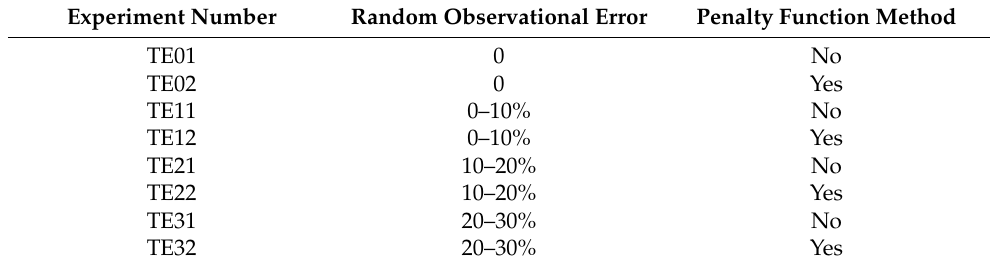
Table 1. Design of twin experiments.